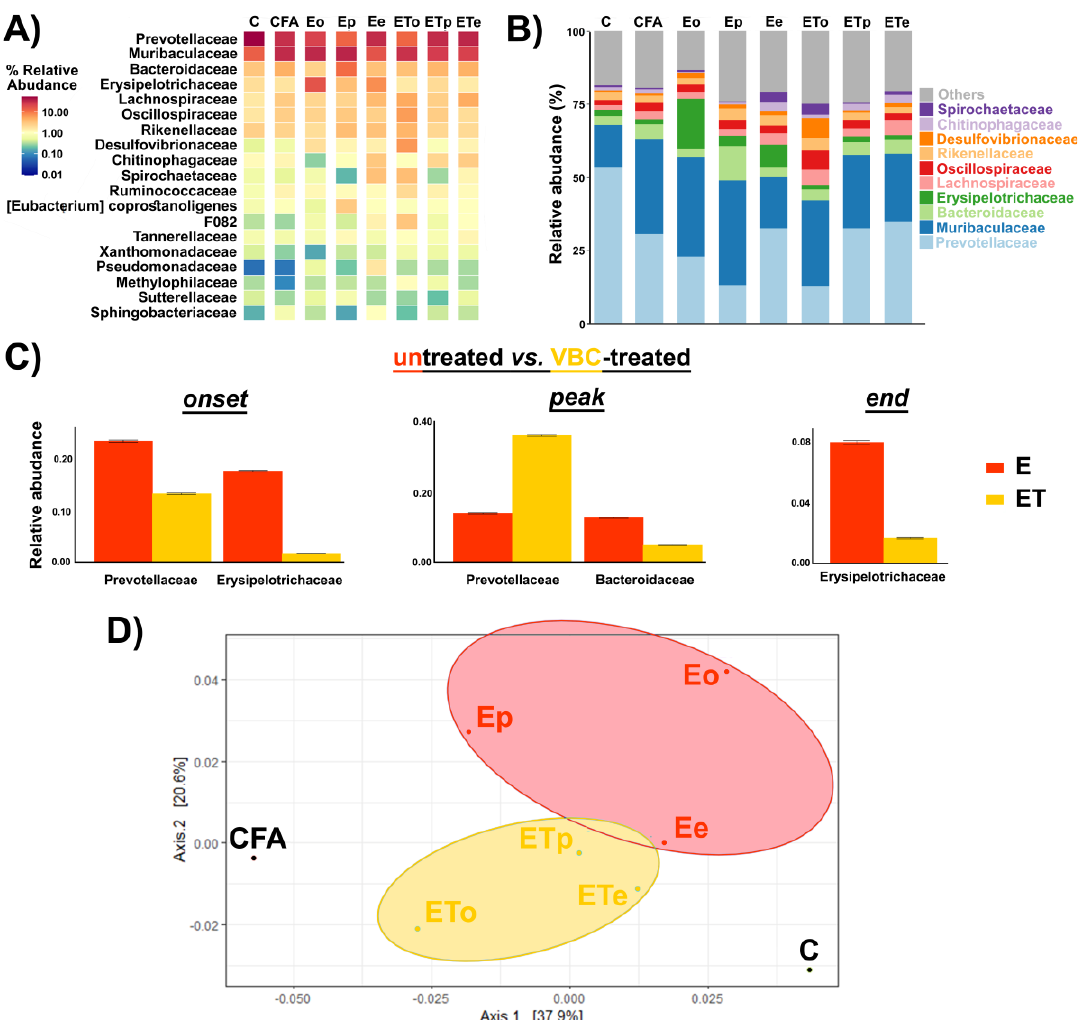
Figure 6. Gut microbiota analysis— ( A ) The abundance-based heatmap of 20 most abundant bacterial families level. ( B ) Relative abundances (%) of top 10 identified bacterial families. ( C ) Differentially abundant families between untreated and VBC-treated animals based on metastat method. ( D ) Principal component analysis (PCA) and clustering of the gut bacterial communities based on log transformed weighted Unifrac distance. Untreated EAE rats ( E ), VBC-treated EAE rats ( ET ) in three different time points: onset ( o ), peak ( p ), and end ( e ) of the disease, control intact rats ( C ), and rats s.c. injected only with Complete Freund’s adjuvant ( CFA ). Percentage values in parentheses represent a percentage of variance explained by each component.